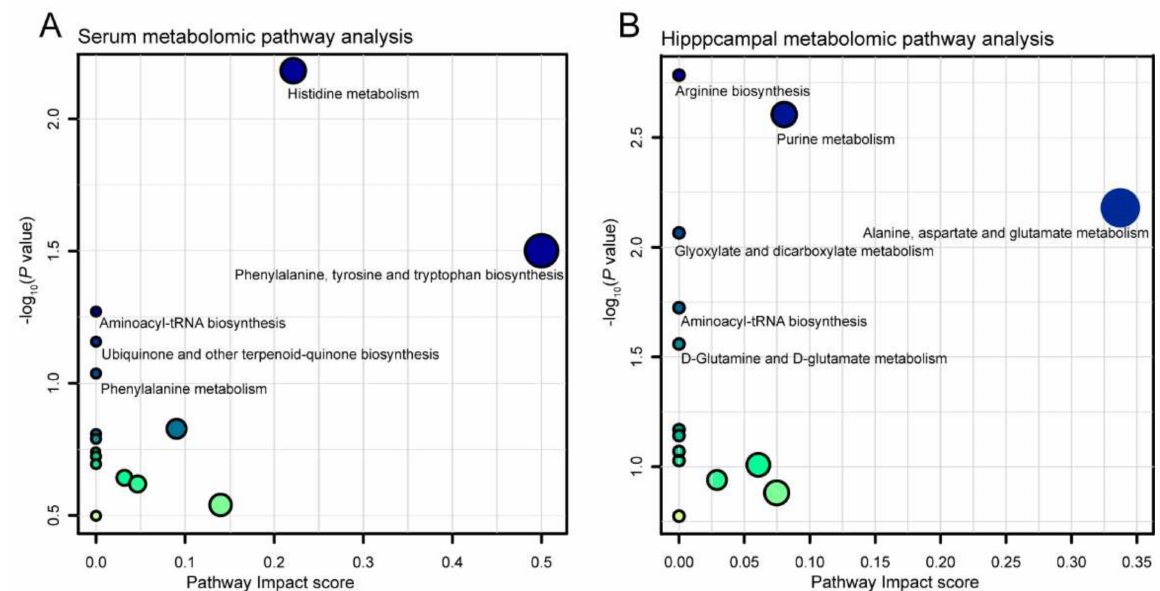
Figure 5. Scatterplot showing results of MetaboAnalyst Pathway analysis using the Mus musculus (mouse) pathway library. ( A ) Serum; ( B ) hippocampus.